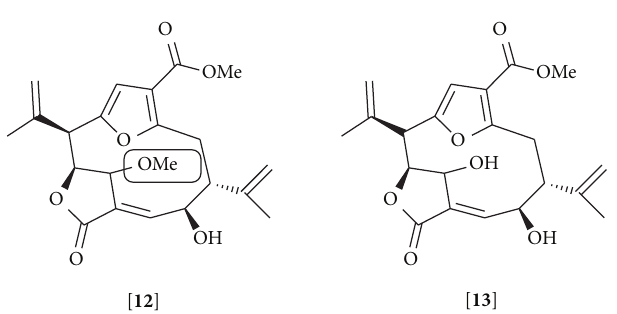
Figure 6: Pseudopterolide derivative [ 12 ] and isogorgiacerodiol [ 13 ]. The methoxyl group at C-9 in pseudopterolide derivative that has been suggested as being responsible for the higher anti-inflammatory effect than isogorgiacerodiol is